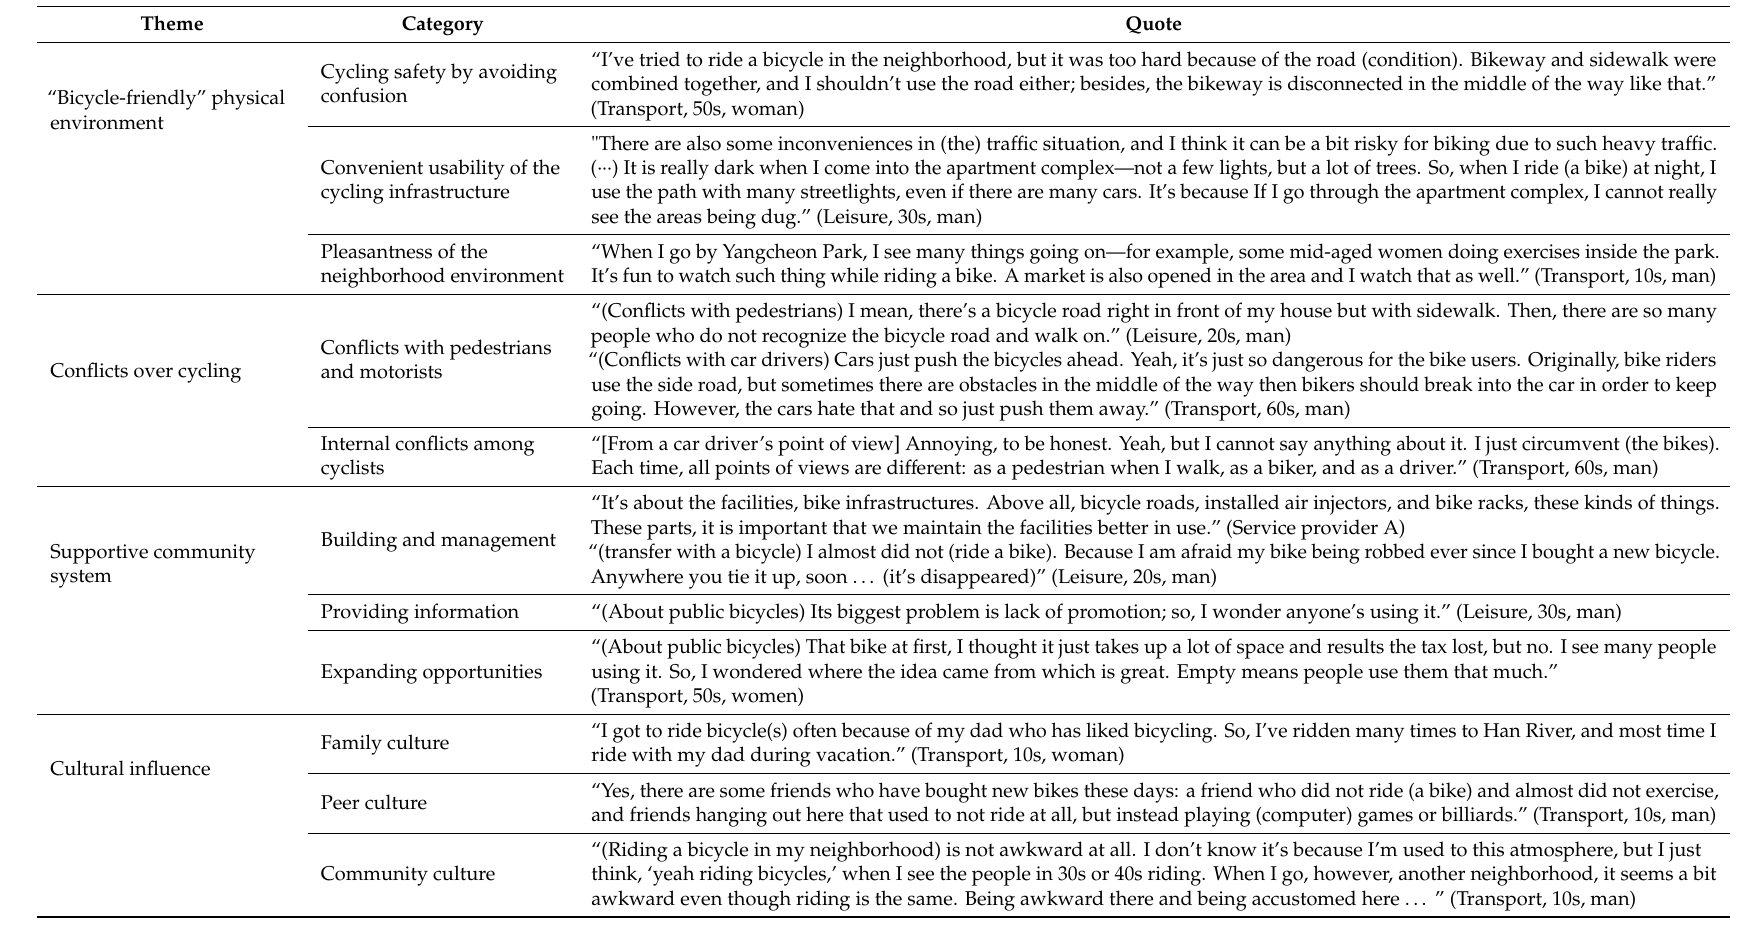
Table 3. Quotations by